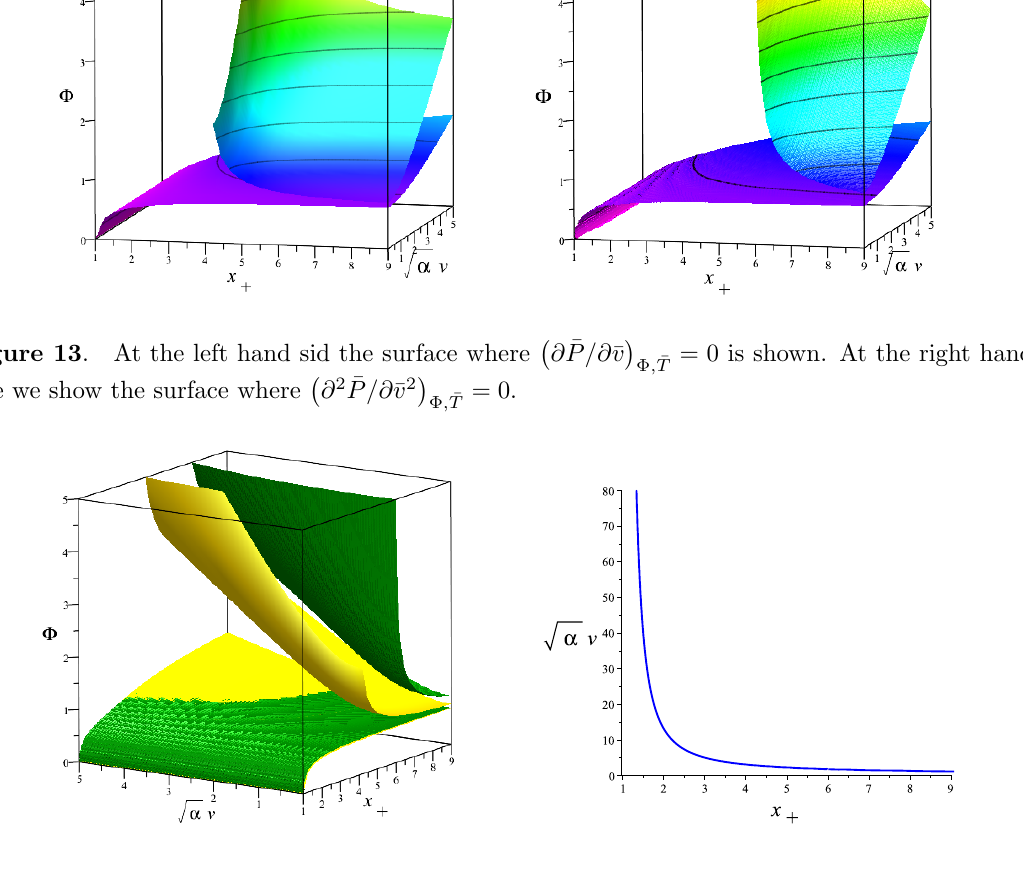
(cid:0) (cid:1) @ (cid:22) P=@ (cid:22) v = 0 and the (cid:8) ; (cid:22) T p 2 < (cid:8) < 1,